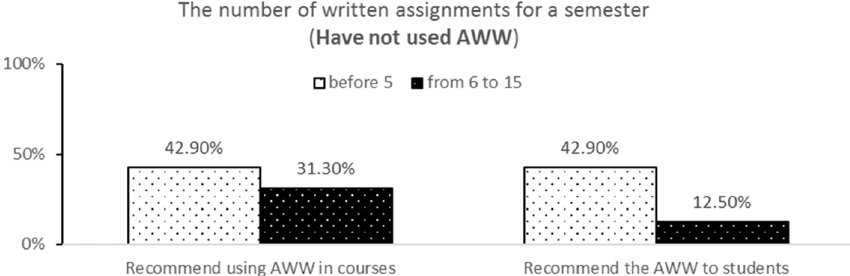
Fig. 9 Frequency of positive questions by number of written assignments for a semester when not using